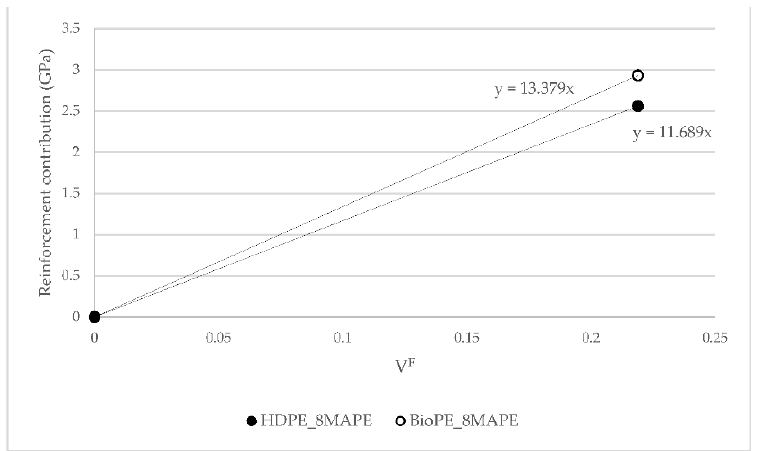
Figure 4. Fiber Tensile Modulus Factor (FTMF) for HDPE and BioPE AF reinforced composites.